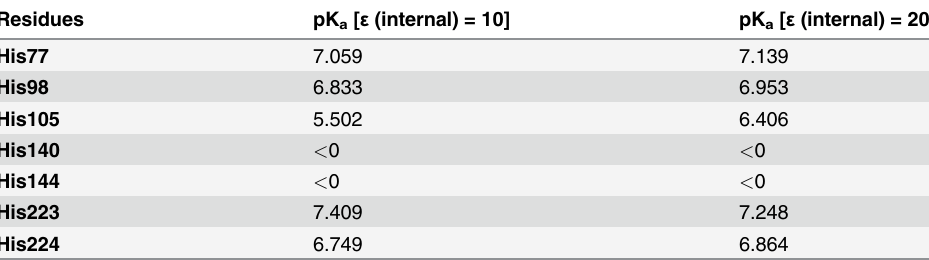
Table 2. Predicted pK a values for histidines in PAE by the H++ server.